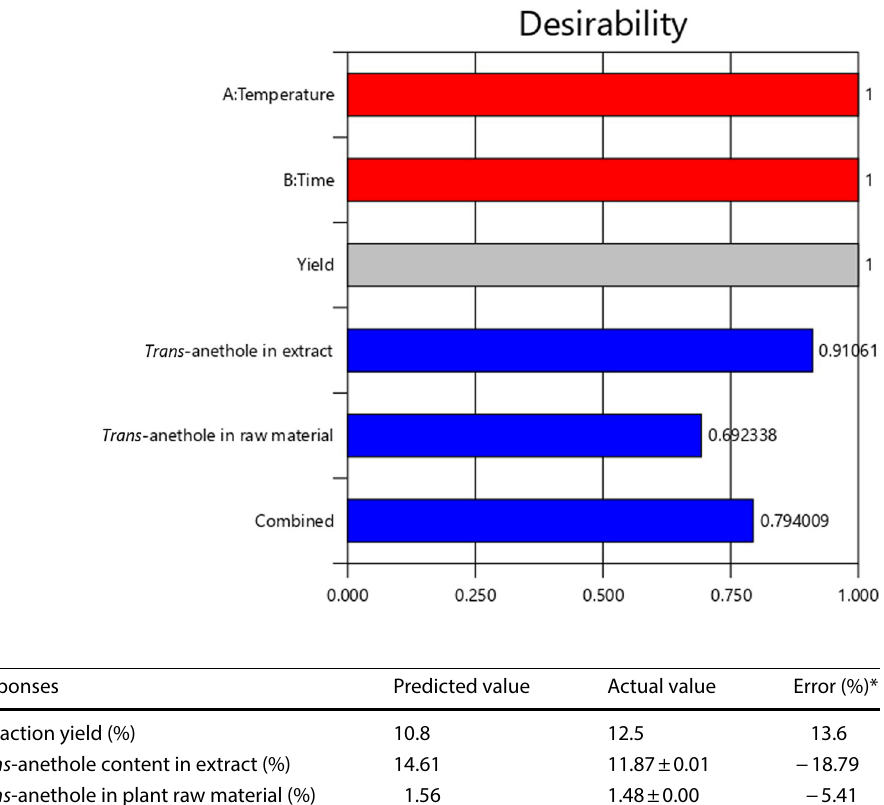
Fig. 5 Desirability chart, when the temperature and time were set as “in range,” extrac- tion yield was set as “none,” and trans -anethole content in extract and plant raw material were set as “maximize”